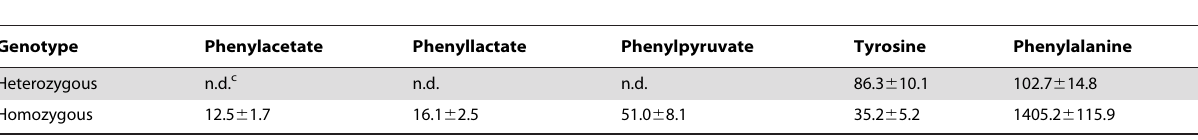
Table 1. Amino Acid and Phenylketone Levels in Plasma of PKU Mice a,b